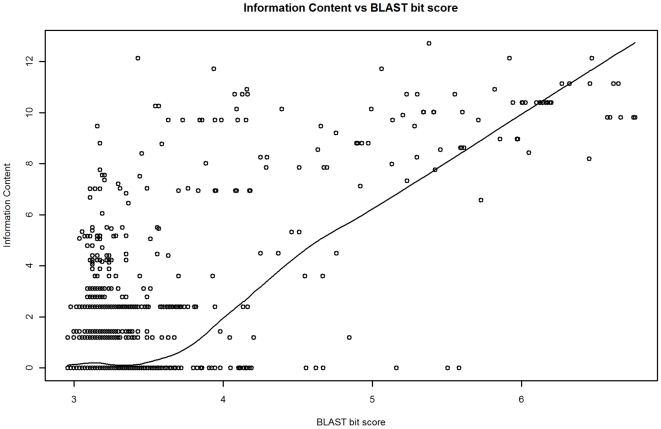
BLAST bit score (log) versus IC.The trend shown is a lowess line. The IC of GO terms generally increases with higher bit scores. IC is less variable than GO level across most bit score ranges, however there remains a significant degree of variability even above a bit score of 6.0.